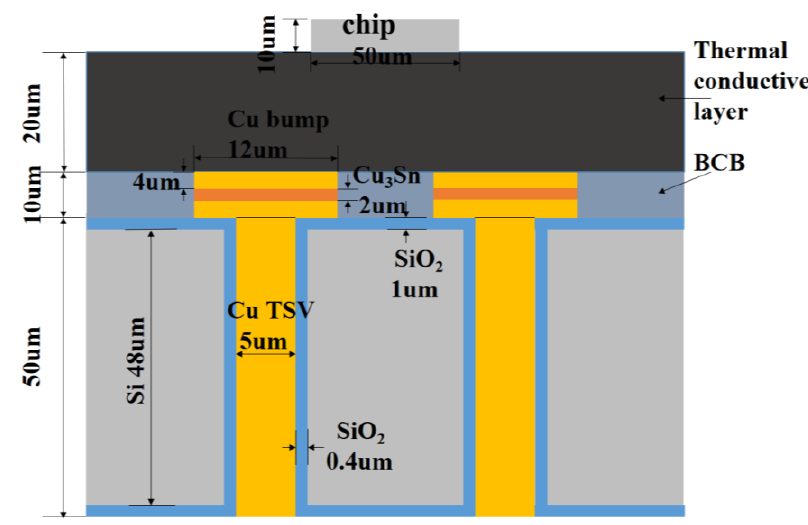
Figure 2. FEM modeling flow chart.